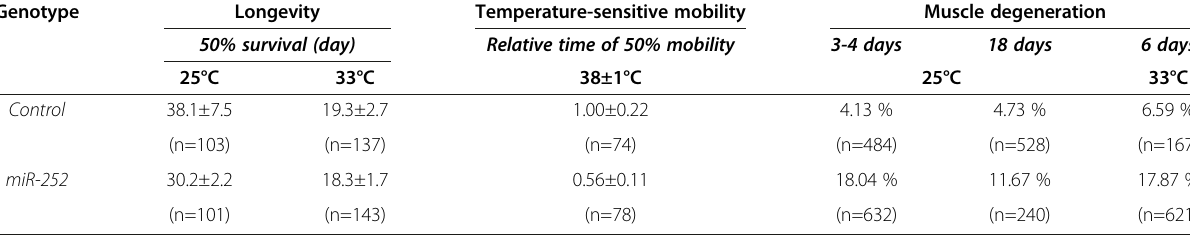
Table 3 Muscular dystrophy-related phenotypes in miR-252 mutants Genotype